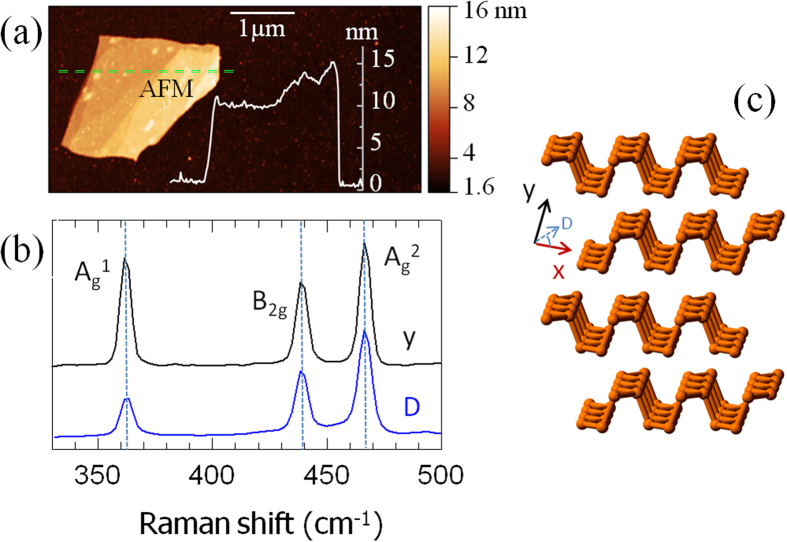
Flake identification and characterization.(a) Atomic force microscopy topographic image of an individual flake with thickness 15 nm. A topographic line profile, acquired along the dashed green line is shown. (b) Micro-Raman spectrum collected by exciting the samples along the z axis with the 532 nm line of a Nd-Yag pumping laser and by varying the polarization between the zigzag (y) and the 45° orientation angle (D axis) between the armchair (x) and y axis. Peaks are found at 362, 440, and 468 cm−1, corresponding to the Ag1, B2g, and Ag2 vibrational modes, respectively. (c) BP atoms are arranged in puckered honeycomb layers bounded together by Van der Waals forces; the armchair (x) and zigzag (y) crystal axis are shown on the graph.